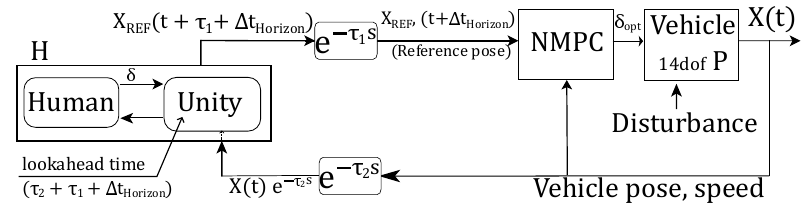
Figure 7. Successive reference-pose-tracking (SRPT)